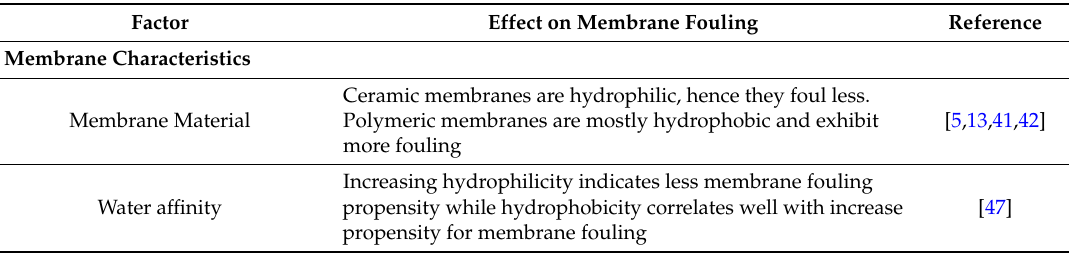
Table 1. Factors affecting membrane fouling in membrane bioreactors